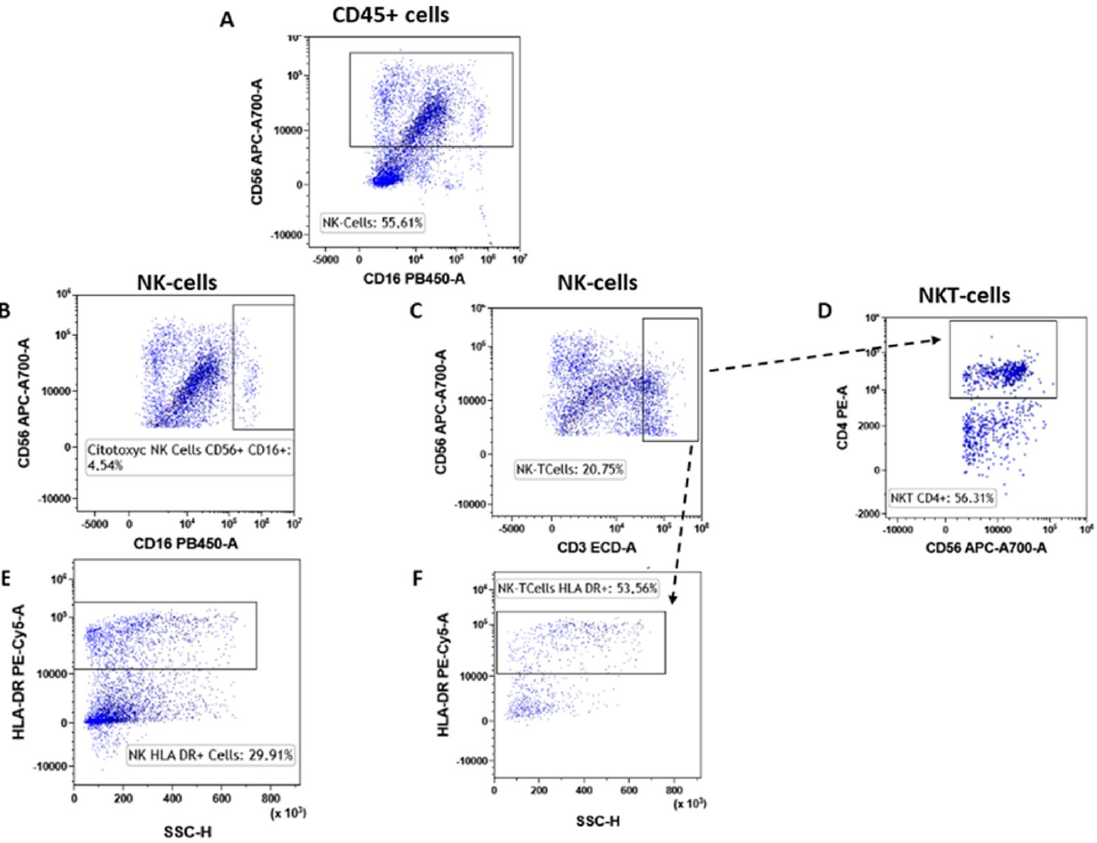
Figure 6. NK subtypes gating strategy. NK cells were selected starting from the CD45 pos event as CD45 pos /CD16 dim cells ( A ). Inside the NK cells, we selected the cytotoxic NK cells (CD56 pos /CD16 pos , ( B ) and NK-T cells (CD56 pos /CD3 pos , ( C ). The NK-T type I cells were selected as CD56 pos /CD3 pos /CD4 pos ( D ). Both NK and NK-T cells were also assessed for their level of activation by determining the expression levels of HLA-DR ( E ) and ( F ). Table 3. Statistical values of the NK lymphocyte subsets. Values are reported as the median percentage of gated